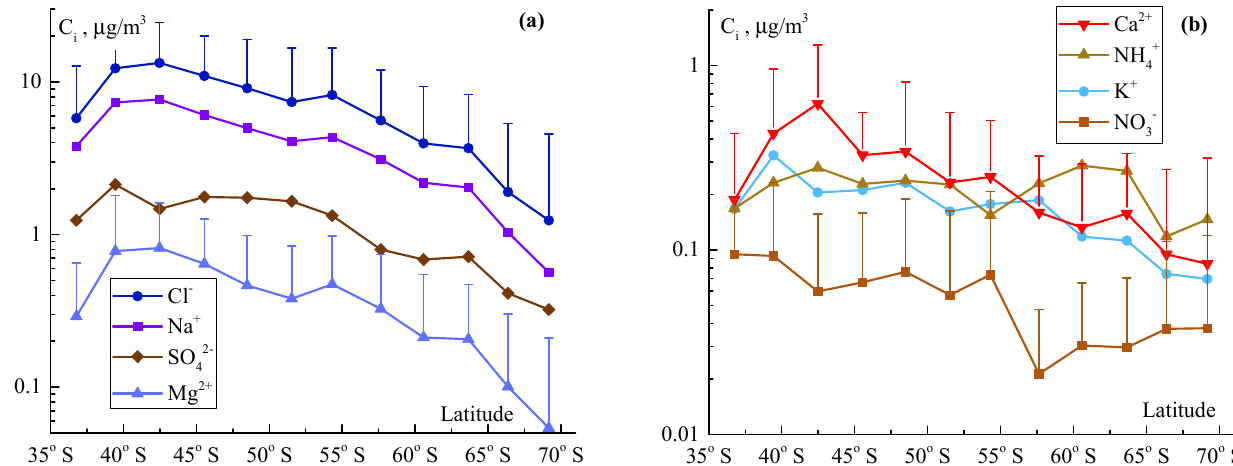
Figure 11. Latitudinal change in the concentrations of different ions in aerosol over the ocean between Africa and Antarctica. ( a ) Cl − , Na + , SO 42 − , Mg 2+ and ( b ) Ca 2+ , NH 4+ , K + , NO 3 − .